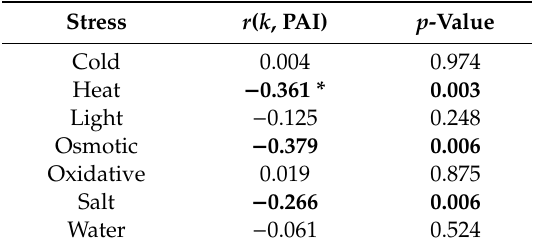
Table 5. Pearson correlation coe ffi cients r ( k , PAI) between the node degree k and its PAI value in gene networks of di ff erent stresses. The second column shows the value of the correlation coe ffi cient, the third one shows the significance level of its di ff erence from 0.